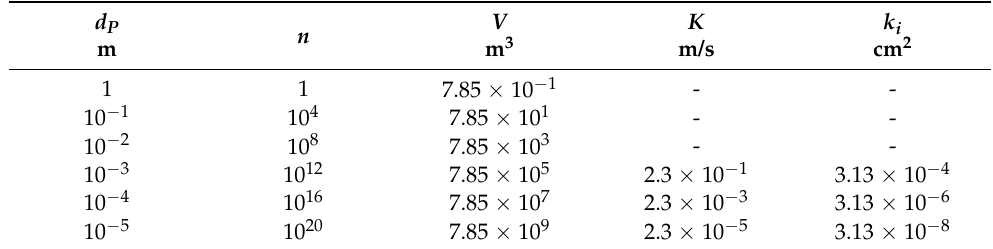
Table 1. Diameter of conduit, d P and relative number of conduits, n , from Equation (19). The volume of all conduits, V , computed by considering constant conduit length, L = 1 m. Hydraulic conductivity, K , and intrinsic permeability, k i , have been estimated by Equation 1 (14).